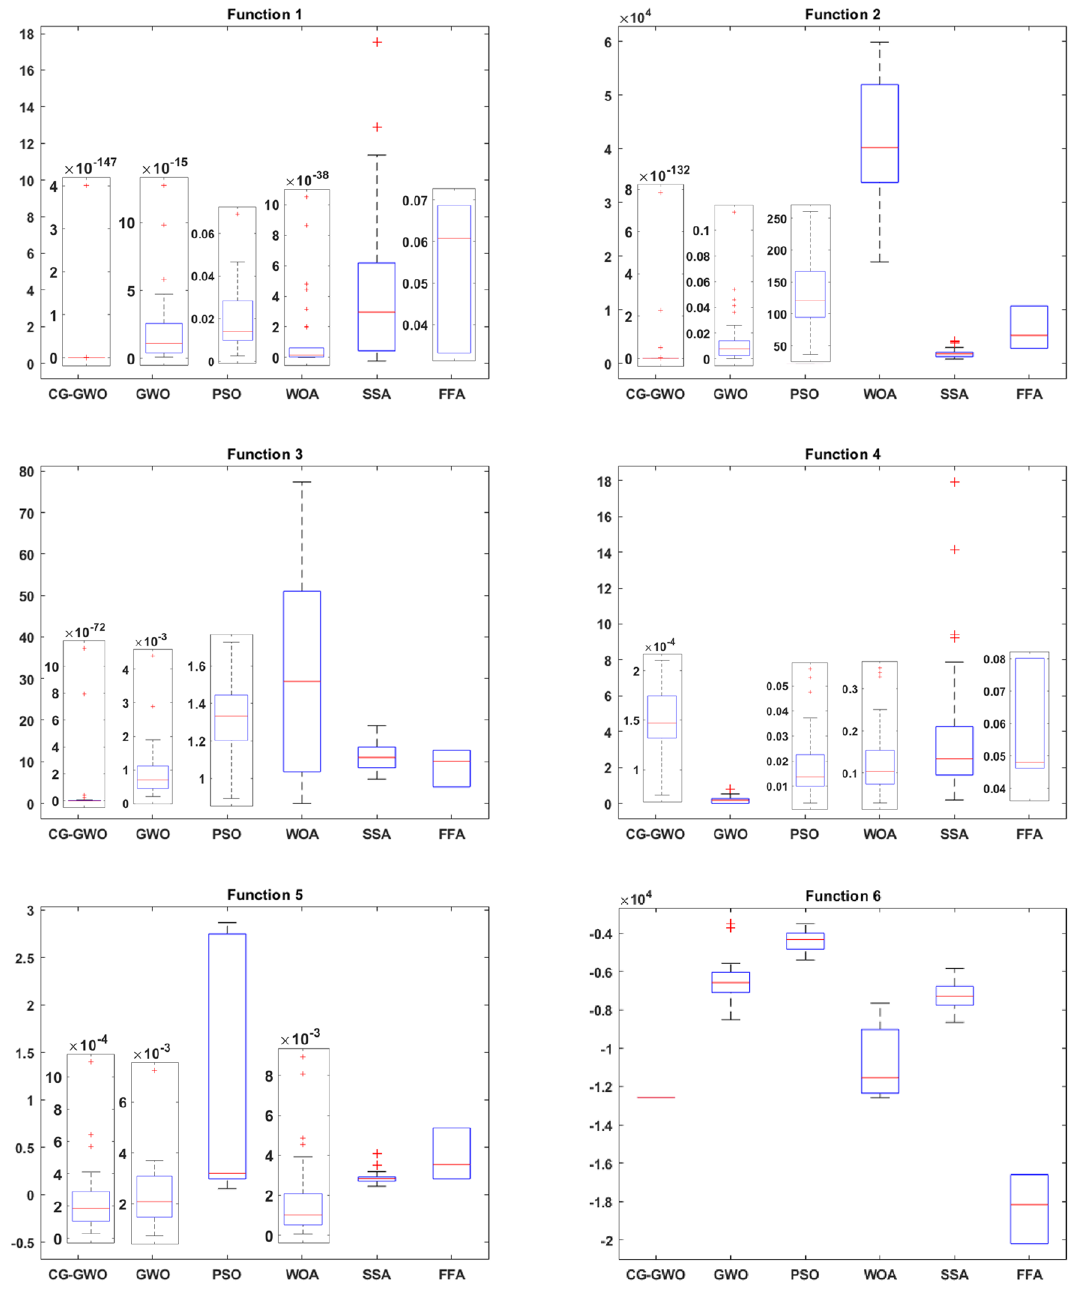
Figure 7. Boxplot comparison of classic optimization